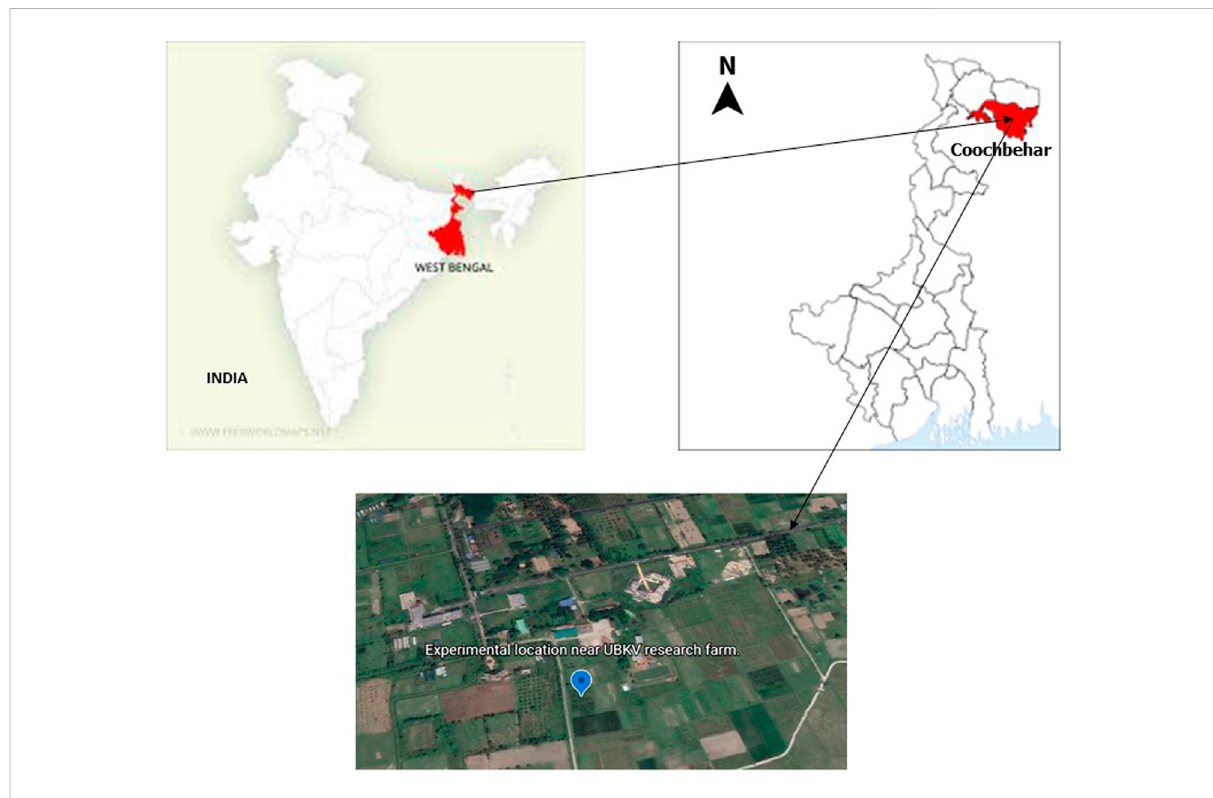
FIGURE 1 Location of experimental